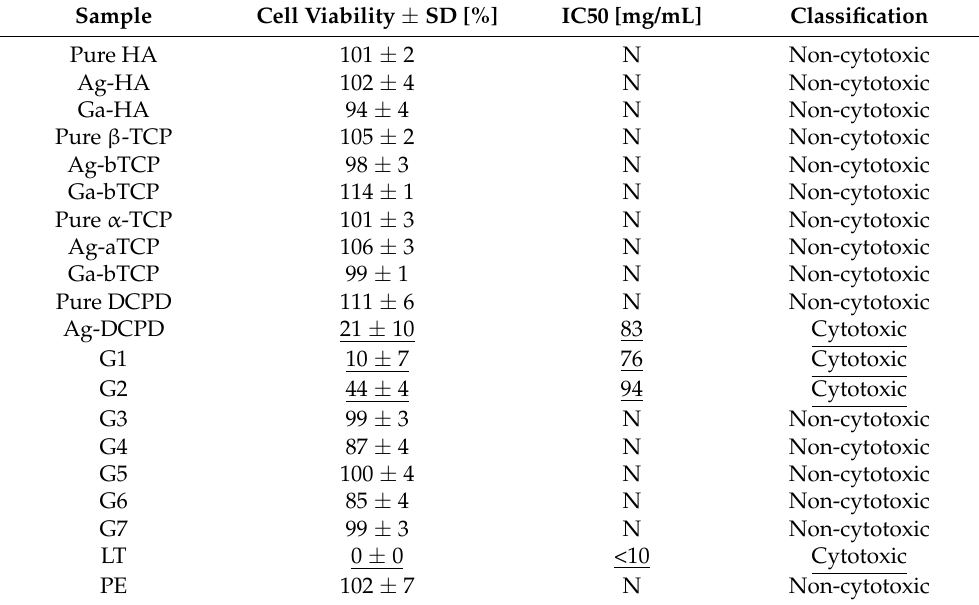
Table 4. Results of the neutral red uptake test for the highest concentrations of tested extracts (100 mg/mL) in comparison to the untreated